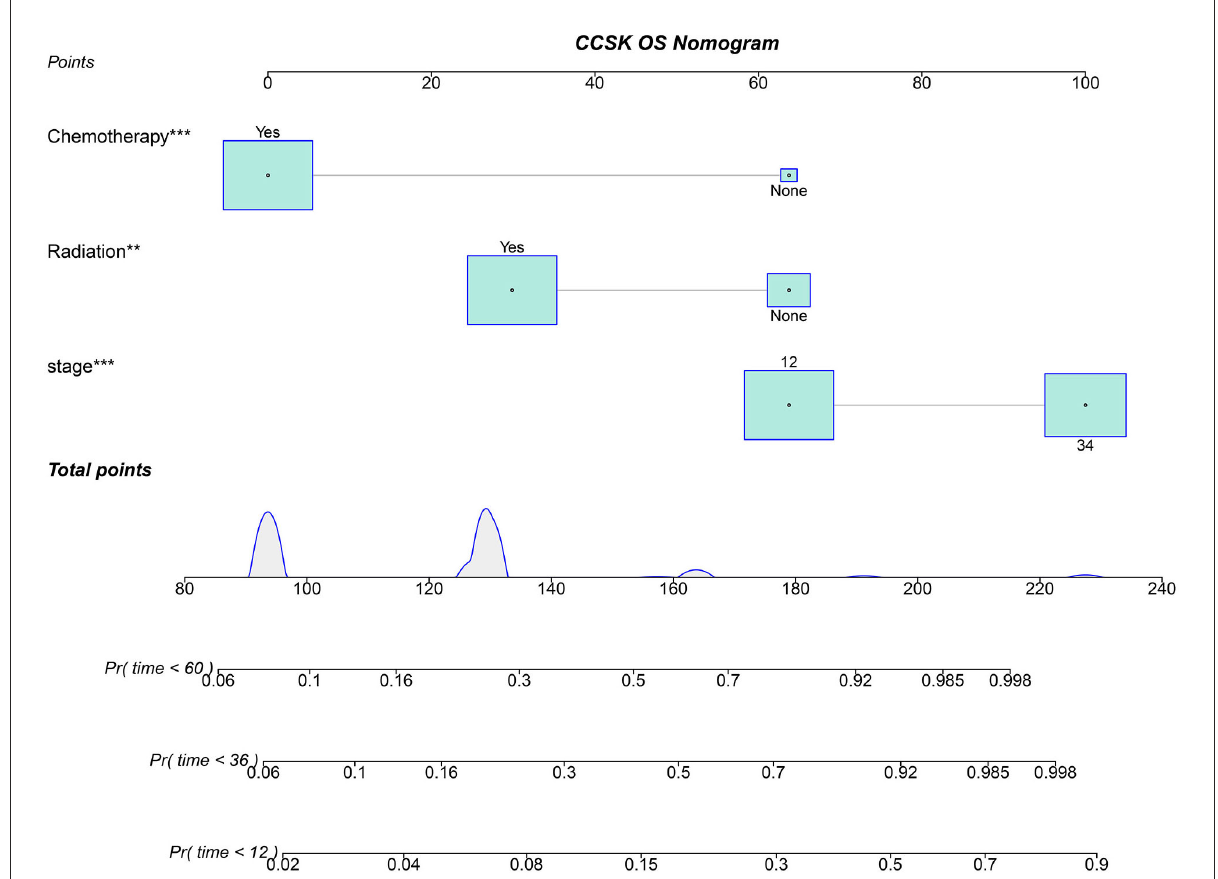
FIGURE2 Nomogram for predicting the OS of CCSK for the 12, 24, and 36 months. 12, stage I and II; 34, stage III and IV; Pr, the probability that the OS of a patient is < 12, 36, and 60 months. *, is an automatically generated label for statistical significance when plotted figure by the R software. The more * appeared, the more statistically